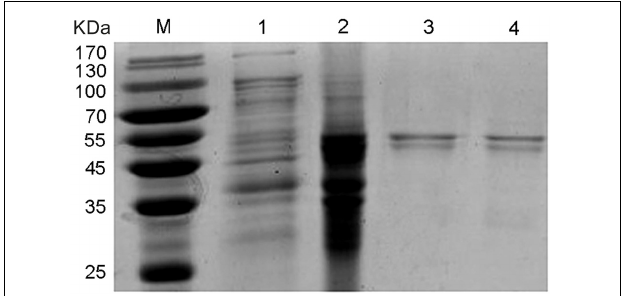
FIGURE 7 | SDS–PAGE gel analysis of recombinant protein NlCDK1. The expression of NlCDK1 expressed in E. coli strain BL21(DE3)/pET32a was induced by 0.5 mM IPTG. The samples were analyzed in 12% SDS–PAGE and stained with Coomassie Brilliant Blue G-250. M: molecular weight markers; Lane 1: total cell lysate of BL21(DE3)/pET32a prior to induction; lane 2: protein of total cells after IPTG induction for 12 h; lane 3: purified and denatured NlCDK1 protein in inclusion bodies; lane 4: purified and refolded NlCDK1